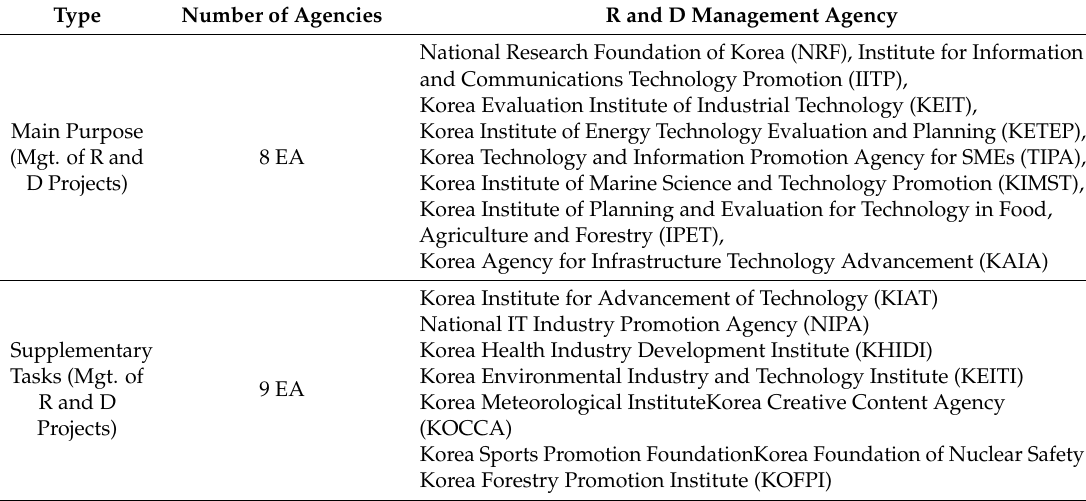
Table 1. Current status of R and D management agencies (2018).